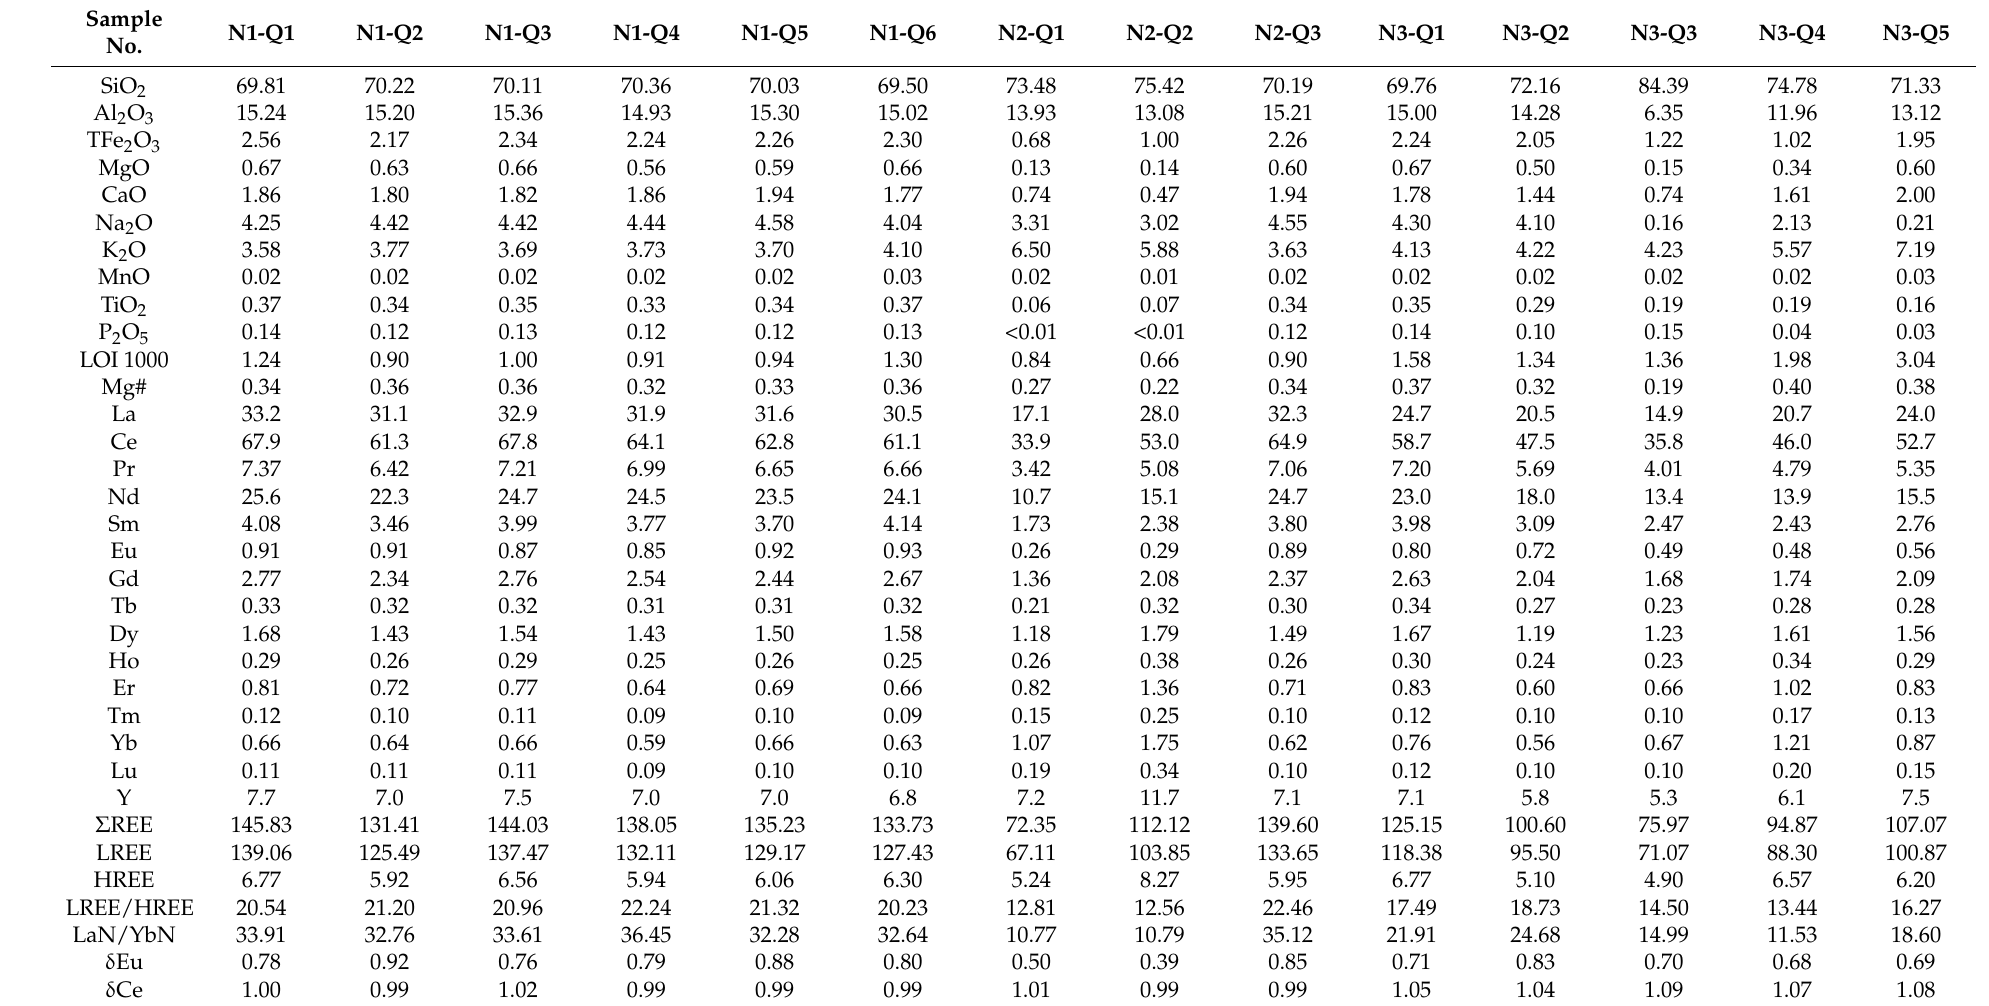
Table 2. Major oxides (wt.%) and trace elements (ppm) compositions for the Chang’anpu monzogranite.